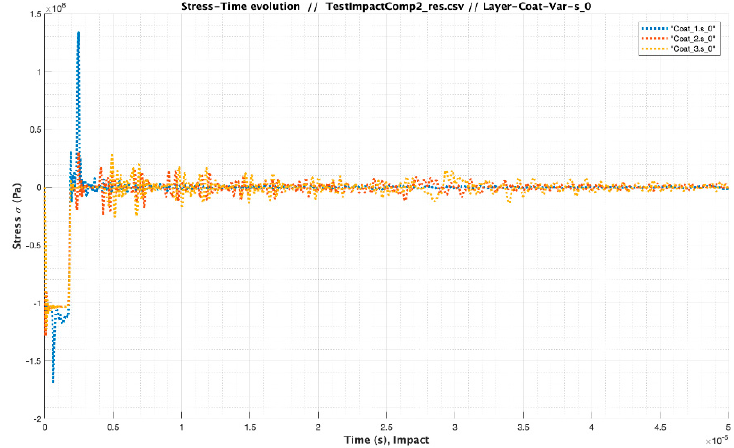
Figure 23. Stress-Time evolution for Cases 1–3 at surface, 0% of Coating thickness, considering the substrate filler as semi-infinite with increased thickness (shells, tapes).